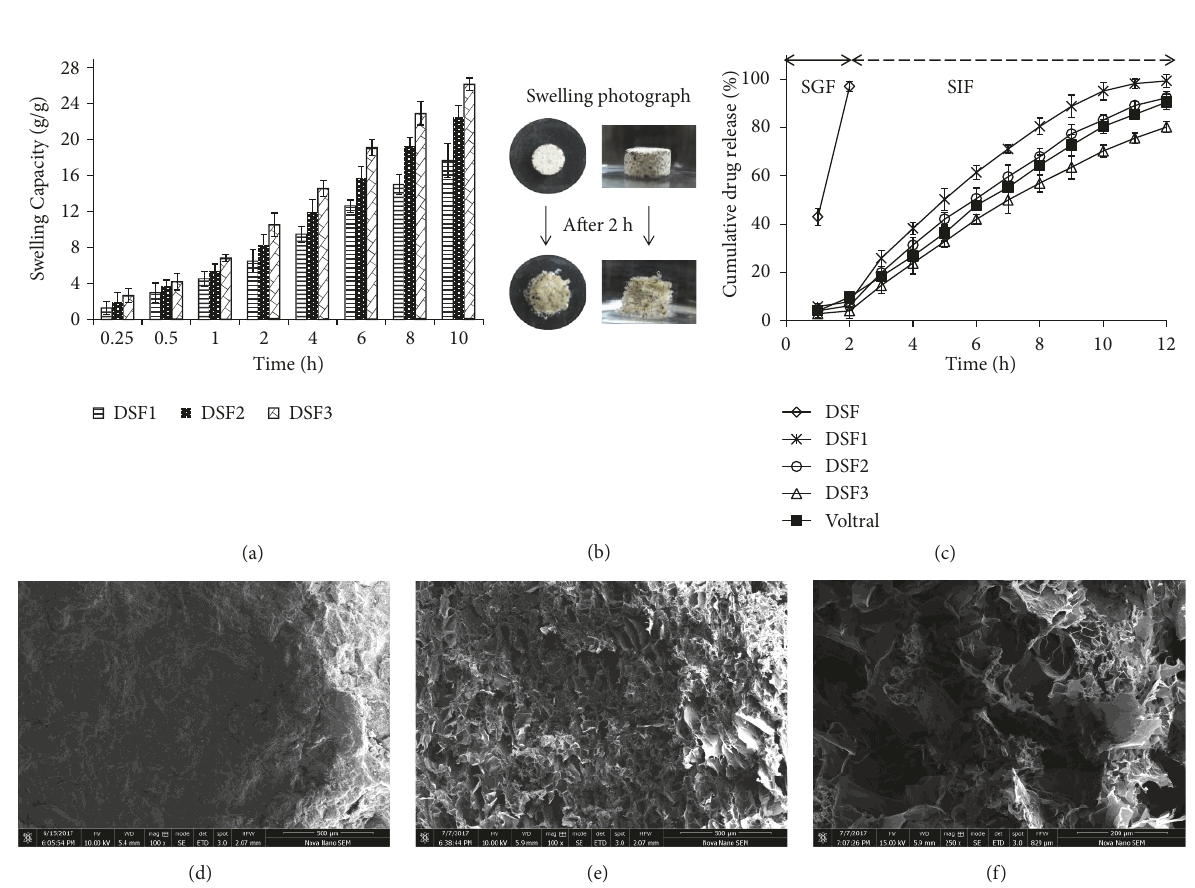
Figure 4: Swelling capacity of different tablet formulation in deionized water after various time intervals (a). Photographs showing swelling of tablets in deionized water (b) and diclofenac sodium release from different formulations, i.e., DSF, DSF1, DSF2, DSF3, and Voltral, in SGF (2 h) and SIF (10 h) (c). SEM images of BSH containing tablet formulation (DSF3); tablet surface (d), tablet surface after swelling in